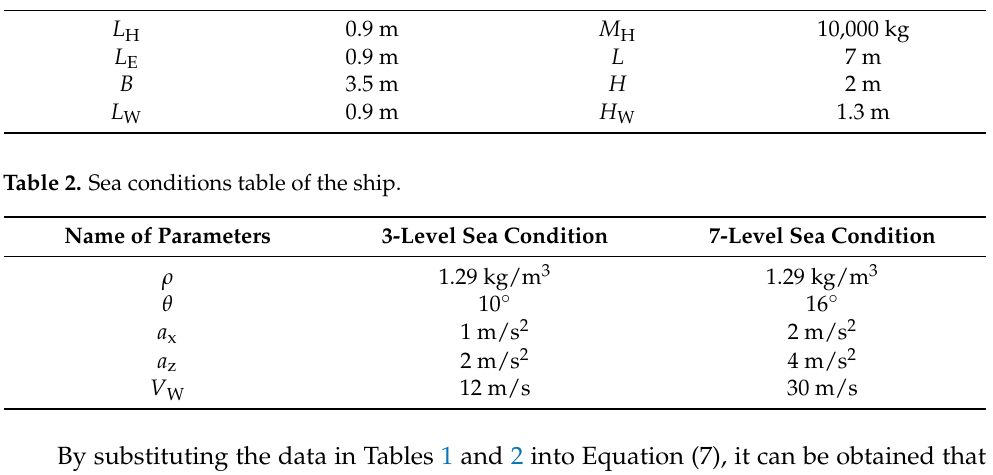
Table 1. Parameters of the shipborne helicopter. Name of Parameters Value